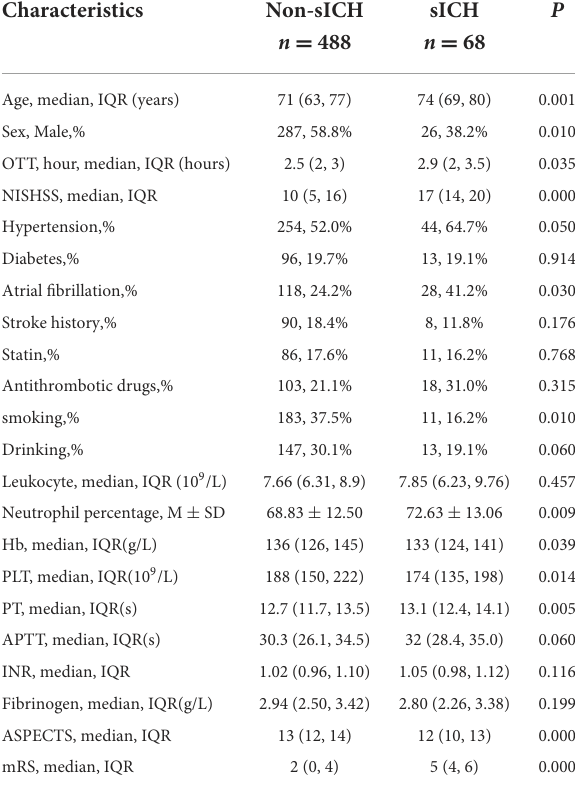
TABLE 2 Demographics and baseline characteristics of patients with and without sICH in the validation cohort.